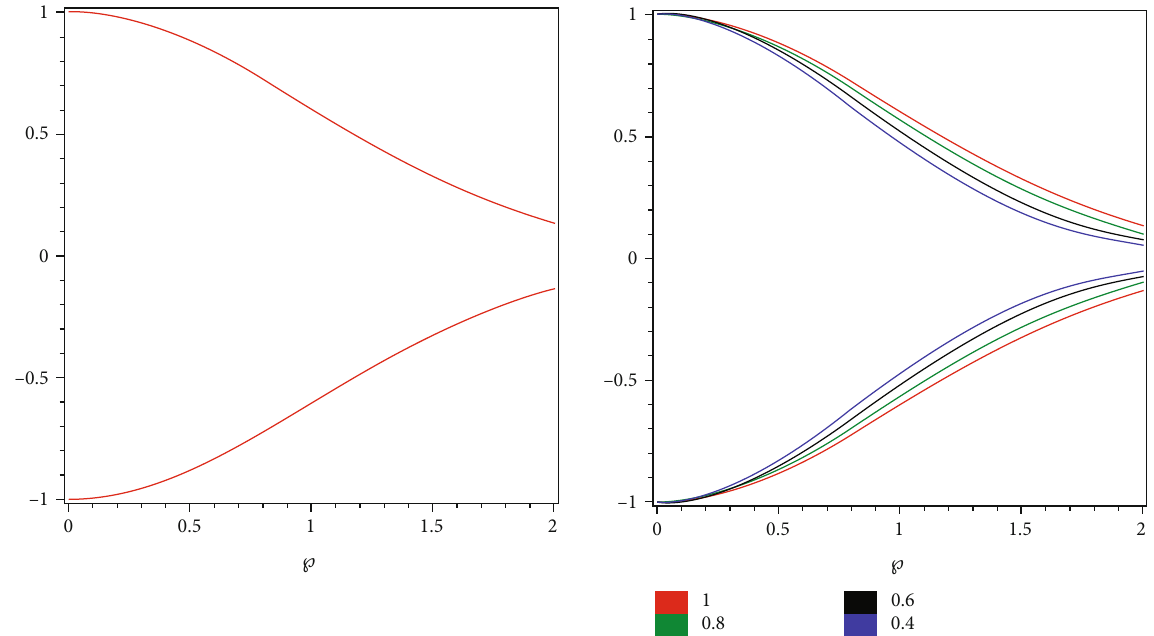
Figure 2: The 1st graph illustrates a two-dimensional fuzzy upper and lower branch graph for an analytic series, while the second illustrates numerous fractions of ρ .